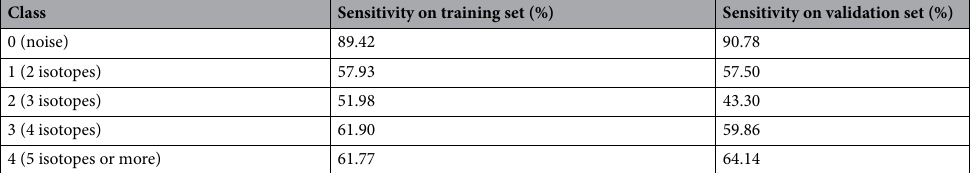
Table 7. Class sensitivity of the IsoGrouping module on the training set and validation set. The output is i = 0 to 4, where i = 0 means that no feature starts in the first frame, so skip it. Output i = 1 to 4 means, there is a feature starting in the first frame, and it ends at ( i + 1 ) th frame. When output i = 4 , it means there might be more isotopes left. So we run another round of processing over the rest of the isotopes of the same cluster or sequence. Therefore, although our network process five frames at a time, if the feature has more than five isotopes, those can be found by overlapping